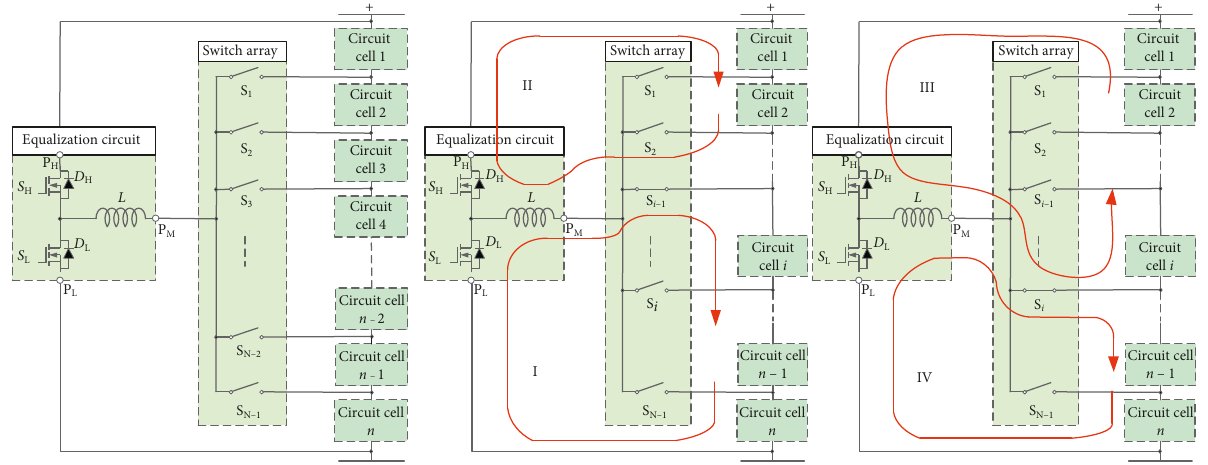
Figure 4: Simplified equalization circuit and its working principle. (a) Simplified equalization circuit, (b) when switch S when switch S i is closed.